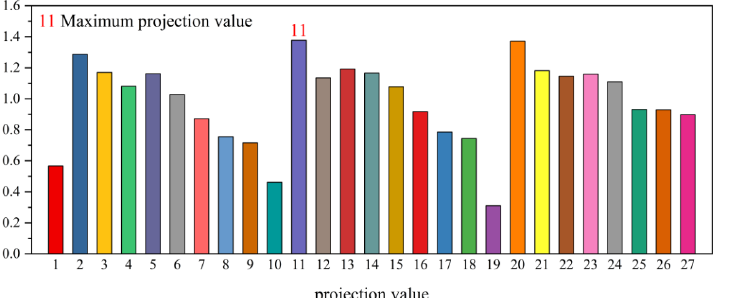
Figure 7. 27 scatter plots of the projection values and sample number of the different hidden tube layout parameters. layout